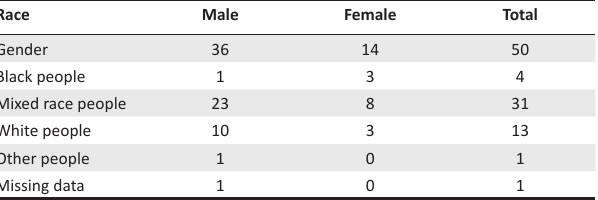
TABLE 1: Demographic details of the participants who completed the WHODAS